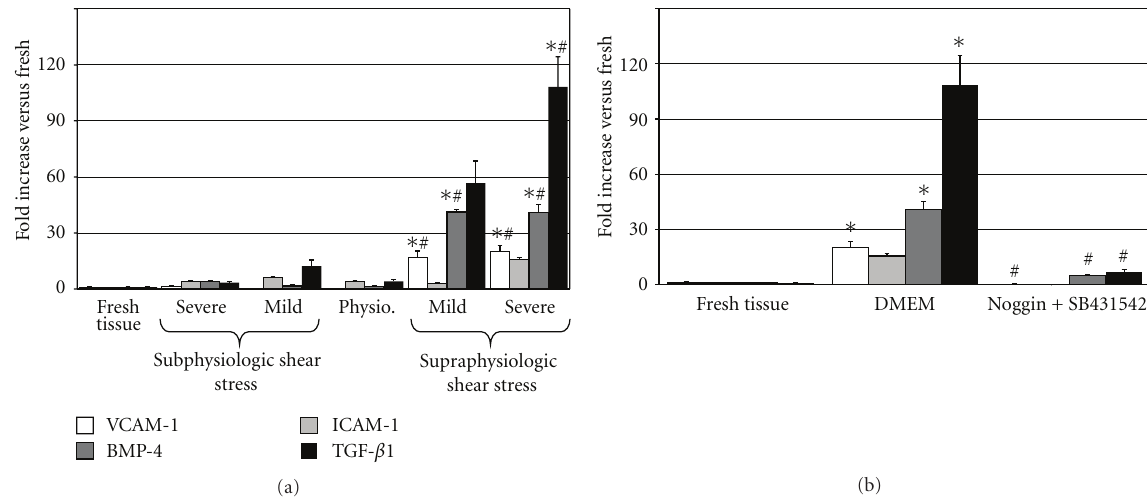
Figure 6: Cytokine and cell-adhesion molecule expressions after exposure of the fibrosa to (a) various shear stress magnitudes ( ∗ P < . 05 versus fresh; # P < . 05 versus physiologic/subphysiologic) and (b) severe supraphysiologic shear stress in medium supplemented with SB- 431542 and noggin ( ∗ P < . 05 versus fresh; # P < . 05 versus standard medium (DMEM)).